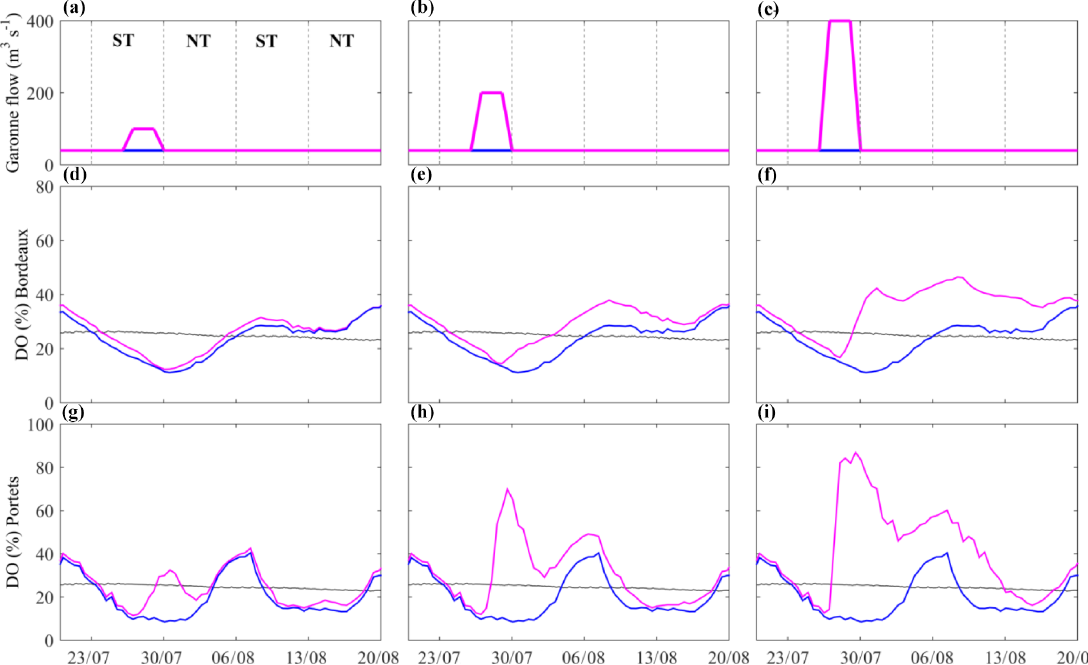
Figure 5. Time series of river flow ( a–c ; m 3 s − 1 ), DO min (over tidal cycle) at Bordeaux ( d–f ; % saturation) and DO at Portets ( g–i ; % saturation) for the scenarios of short river flow increases by 100m 3 s − 1 (a, d, g) , 200m 3 s − 1 (b, e, h) and 400m 3 s − 1 (c, f, i) . The blue line represents the simulation of